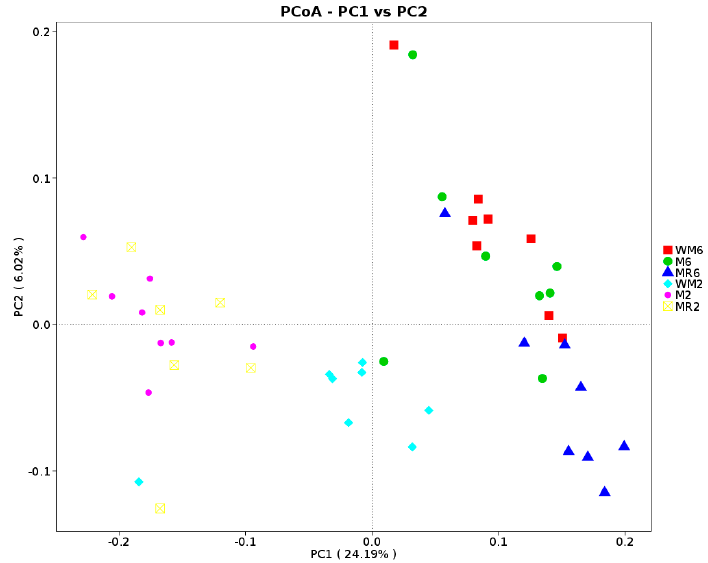
Figure 5. Principal coordinate analysis of beta-diversity of the rumen bacterial community based on unweighted UniFrac distances . . WM2, M2, and MR2: rumen liquid was sampled at the age of two months from calves fed waste milk, milk or milk replacer, respectively. WM6, M6, and MR6: rumen liquid was sampled at the age of six months from calves fed waste milk, milk, or milk replacer,